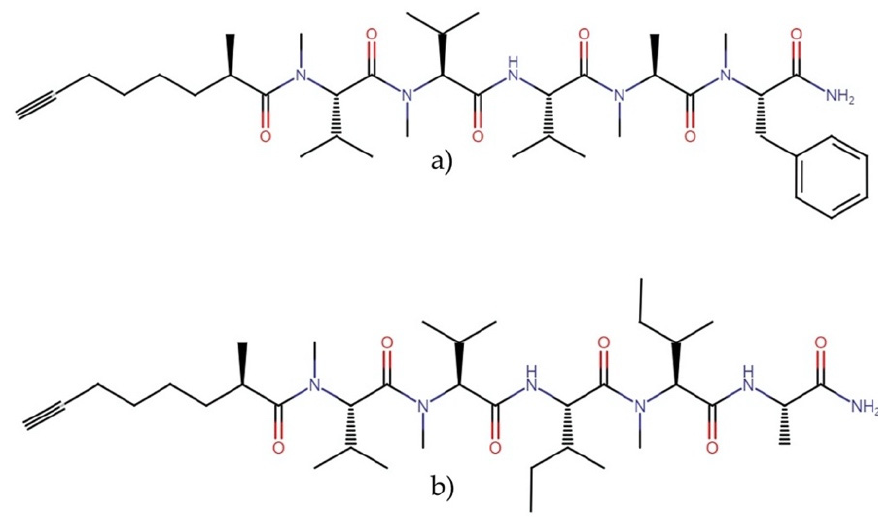
Figure 13. Chemical structures of ( a ) almiramide B and ( b ) almiramide D. Microcolins are lipopeptides isolated from the cyanobacteria Moorea producens and Lyngbya polychroa (Figure 14).